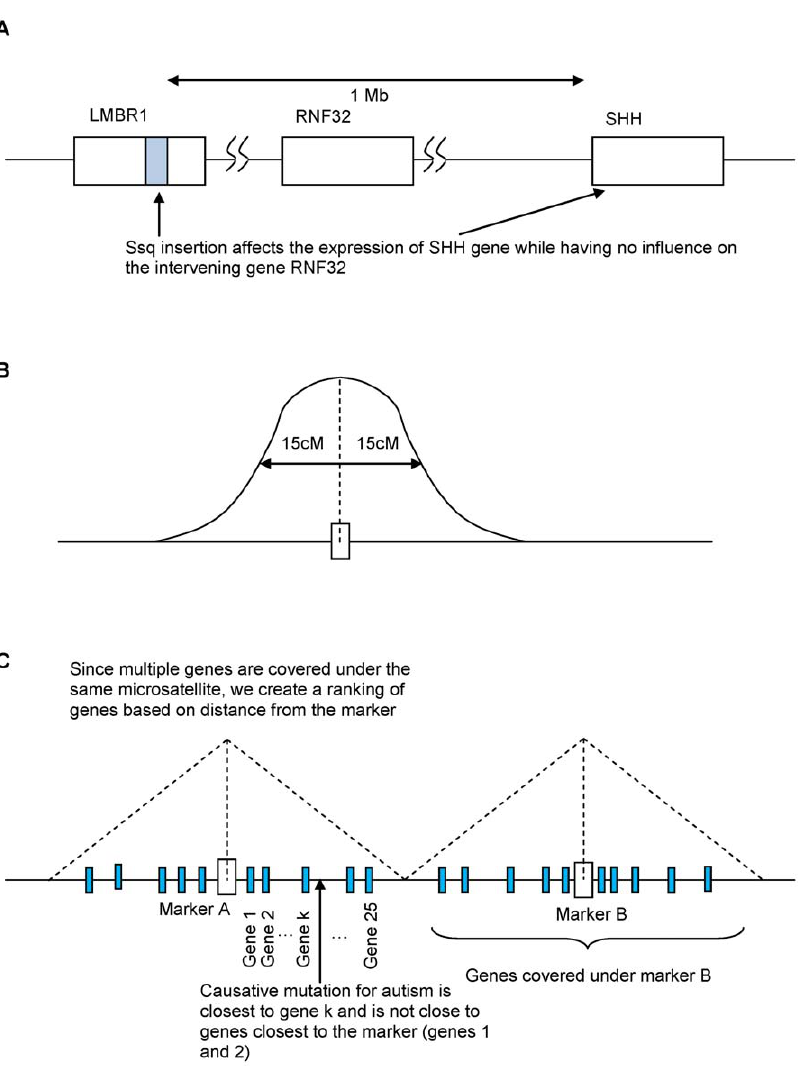
Figure 5. Why the closest gene is not necessarily the best gene. A. Far away genes can be influenced by genes closer to a marker. Thus, we can’t just use the closest genes to the marker. B. Since our real locus could be anywhere within the 30 cM window, any of the genes within the window could be the closest gene, and since our best location for the marker is the center of the window, we simply rank the genes from this point to take into account the fact that any of the genes within the window could be the gene closest to some ‘real’ marker. C. The low density of markers means that many genes are ‘covered’ by each marker. The gene of interest may be far from the marker and may not necessarily be the closest gene from the